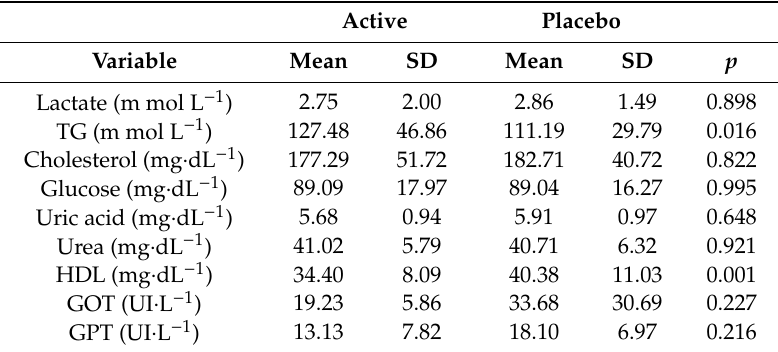
Table 8. Biochemical data after the submaximal